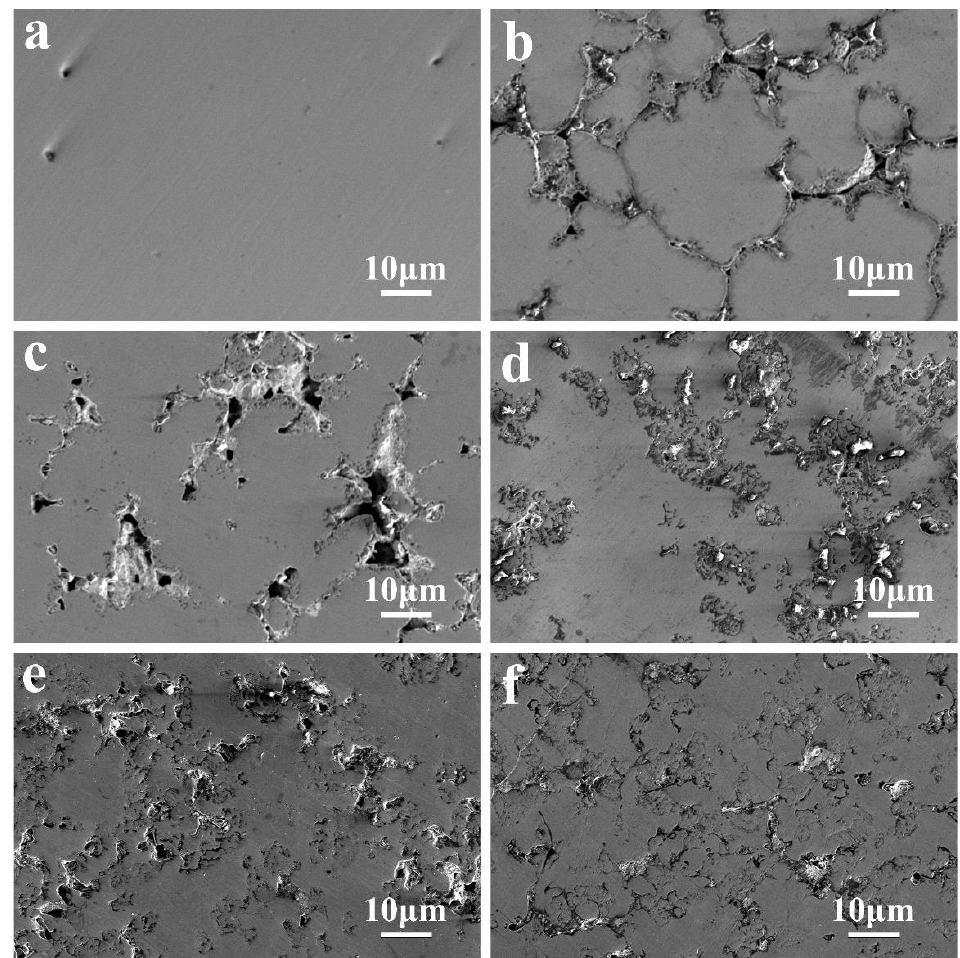
Figure 8. Surface morphology of AlCrTiV 0.5 Cu x lightweight HEAs after kinetic potential polarization tests in 0.6 M NaCl solution. ( a ) x = 0; ( b ) x = 0.2; ( c ) x = 0.4; ( d ) x = 0.6; ( e ) x = 0.8; ( f ) x = 1.0.